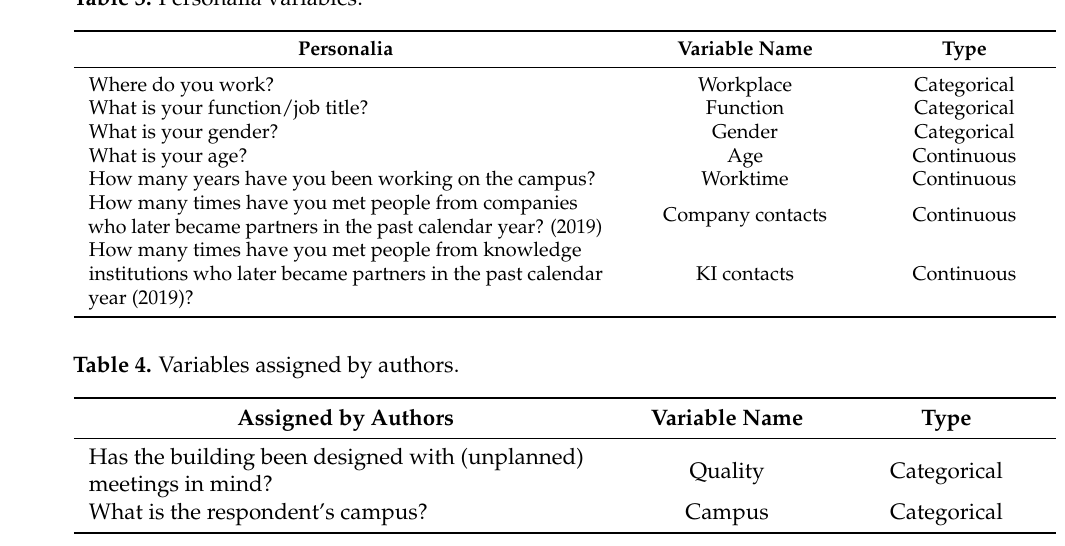
Table 3. Personalia variables.